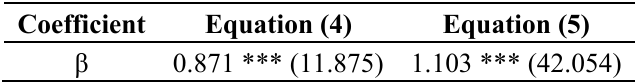
Table 5. Fully modified OLS estimates.